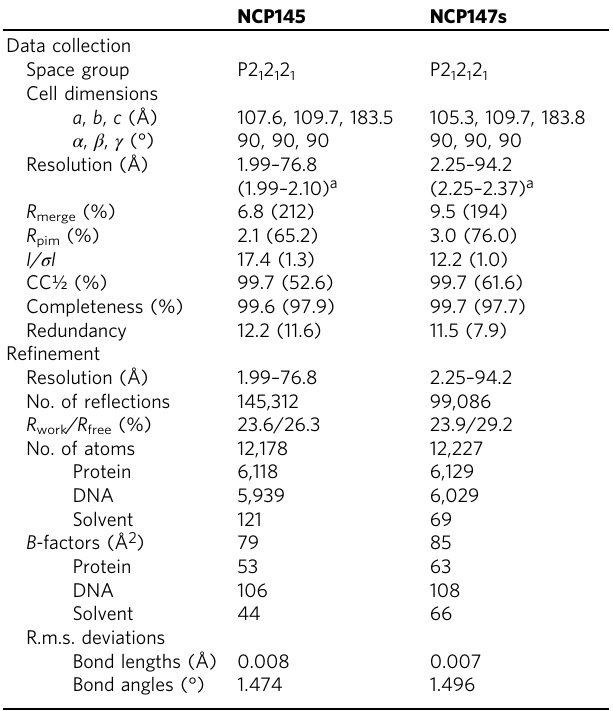
Table 2 Data collection and re fi nement statistics for NCP assembled with H2A and either the same blunt-end 145 bp DNA fragment (NCP145) used for the H2A.X structure or the same sticky-end 147 bp DNA fragment (NCP147s) used for the γ H2A.X